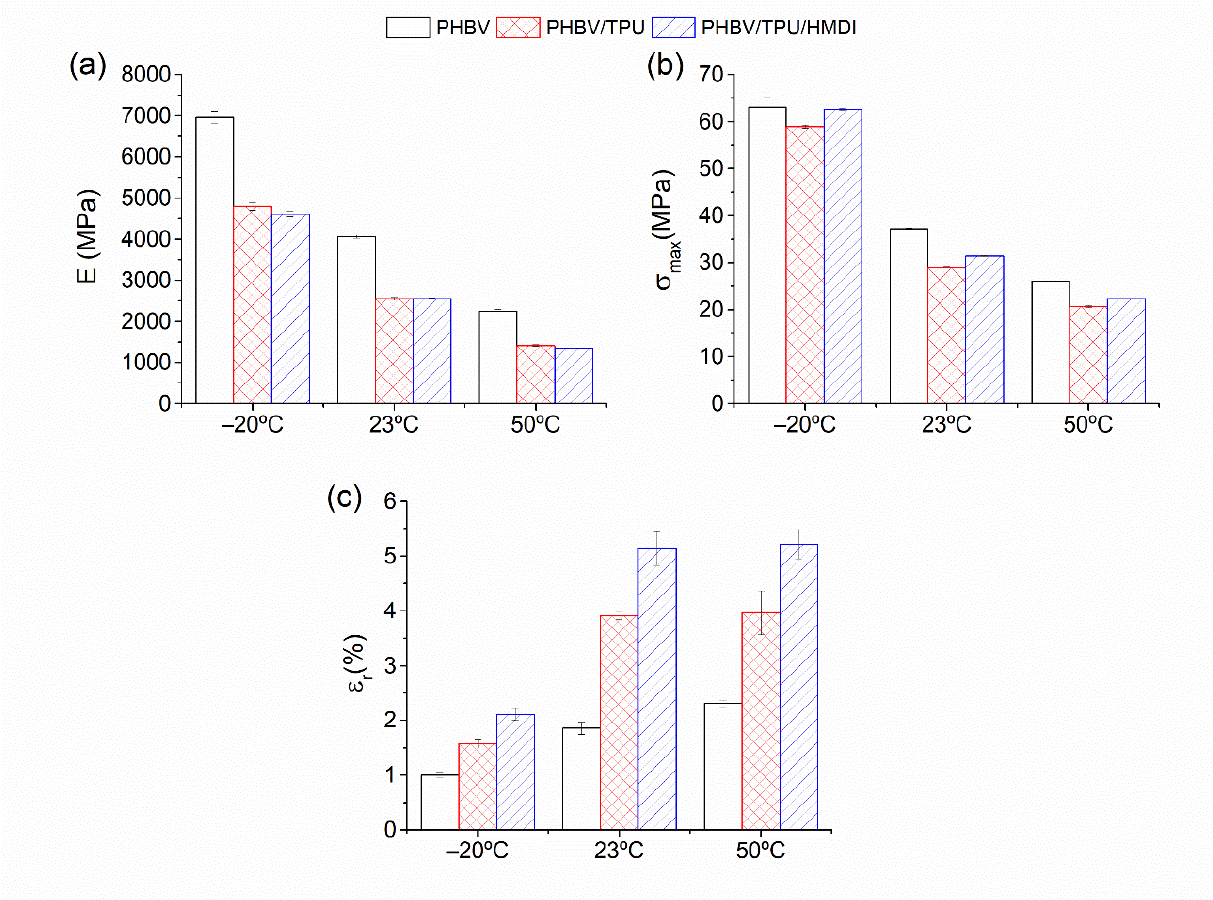
Figure 8. The tensile mechanical properties of the neat PHBV and the PHBV/TPU blends as a func- tion of testing temperature: ( a ) Modulus of elasticity, ( b ) tensile strength, and ( c ) strain at break.